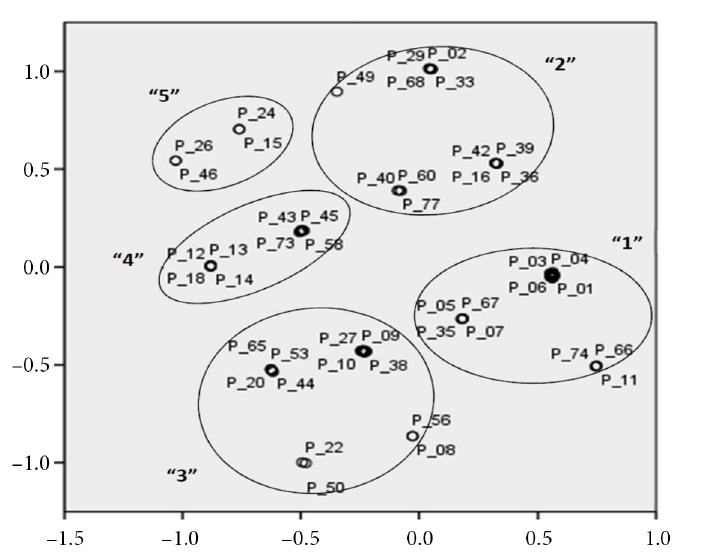
Figure 3. Papers’ mapping according to patterns on research background